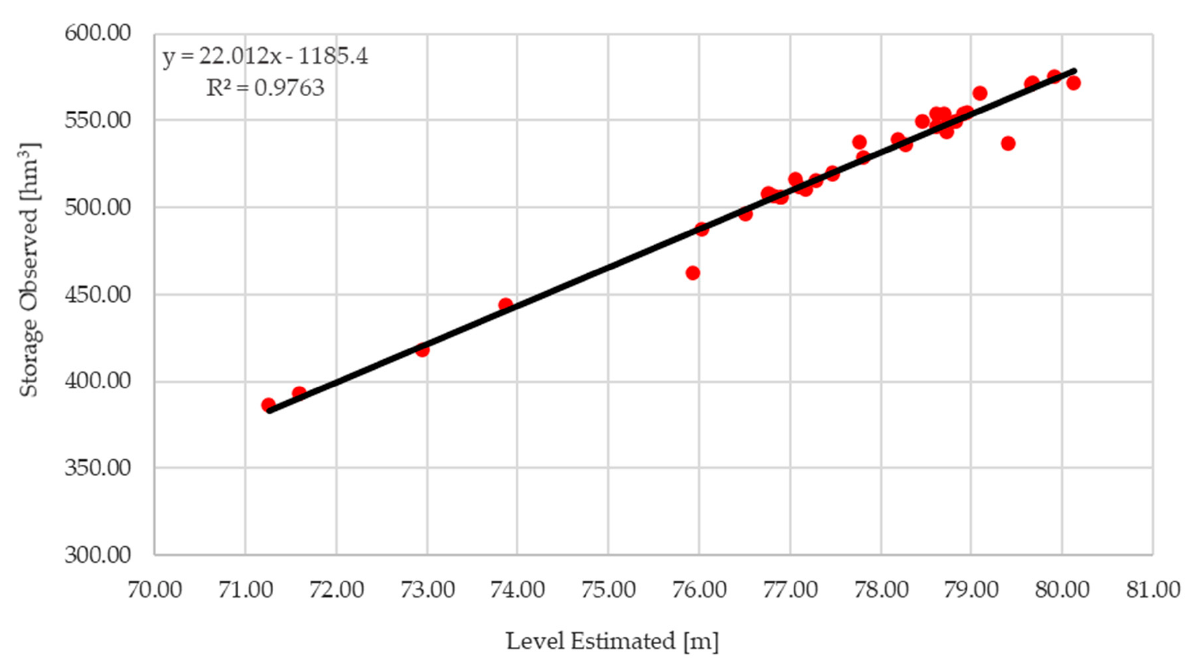
Figure 8. Yliki reservoir water level and storage linear relationship.